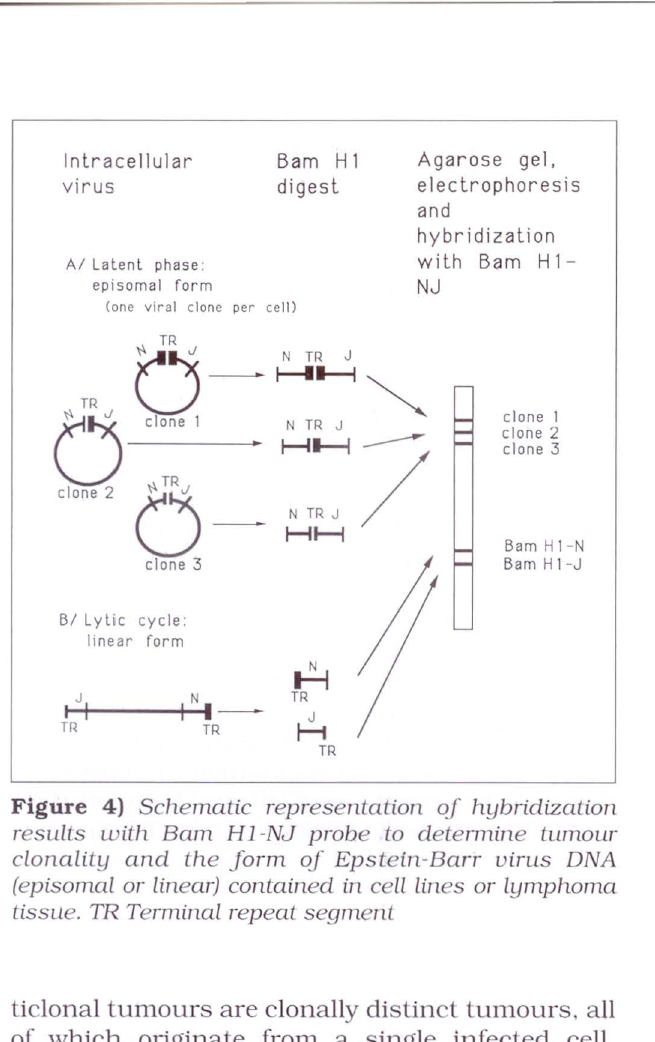
ticlonal tumours are clonally distinct tumours, all of which originate from a single infected